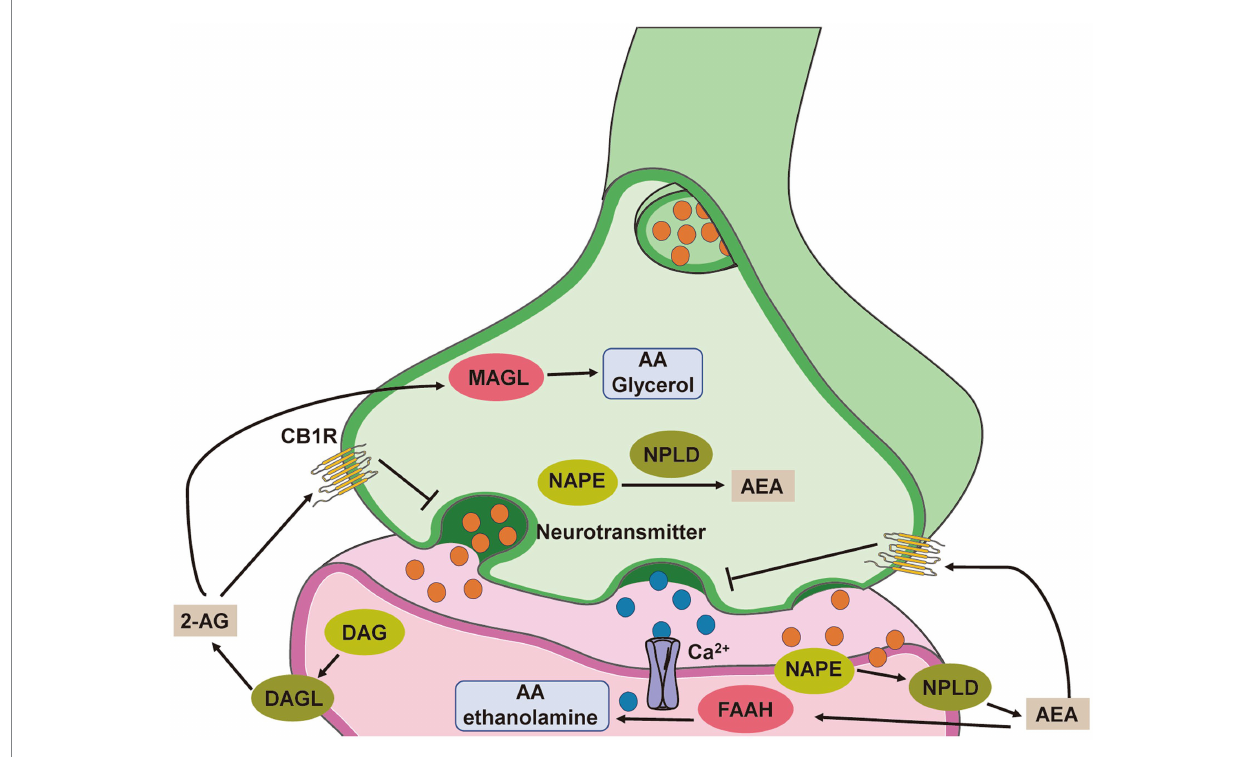
FIGURE 1 Simplified scheme representing endocannabinoid system-modulated synaptic transmission. The endocannabinoids AEA and 2-AG are not stored in vesicles but instead are synthesized de novo from phospholipid precursors through calcium-dependent mechanisms. N-acylphosphatidylethanolamine (NAPE) is hydrolysed by N-arachidonoyl-phosphatidylethanolamine-specific phospholipase D (NPLD) to yield AEA, and diacylglycerol (DAG) is converted to 2-AG by diacylglycerol lipase (DAGL). Both endogenous ligands traverse the synaptic cleft and activate presynaptic CB1 receptors, thereby regulating ion channels and ultimately suppressing neurotransmitter release. Endocannabinoid signalling is terminated following degradation by hydrolytic enzymes in the presynaptic and postsynaptic compartments. Primarily, AEA is converted to arachidonic acid (AA) and ethanolamine by fatty acid amide hydrolase (FAAH) localized to the postsynaptic cell, whereas 2-AG is hydrolysed presynaptically into AA and glycerol by monacylglycerol lipase